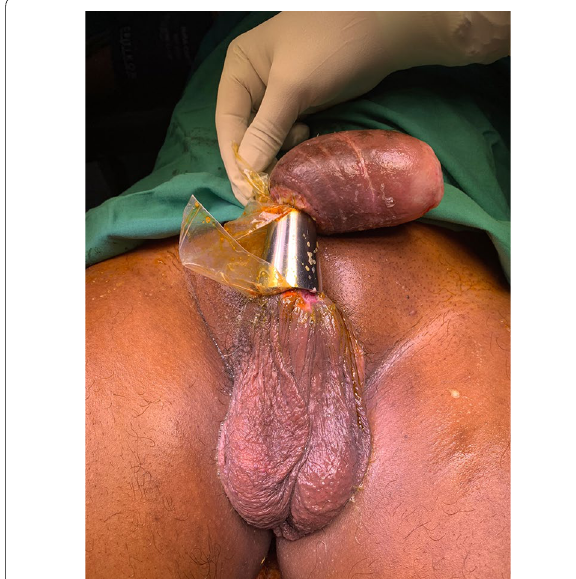
Fig. 1 Metal cone encircling the proximal penile shaft with polythene underneath it. Gross oedema of the penile shaft and prepuce distal to the metal cone is evident